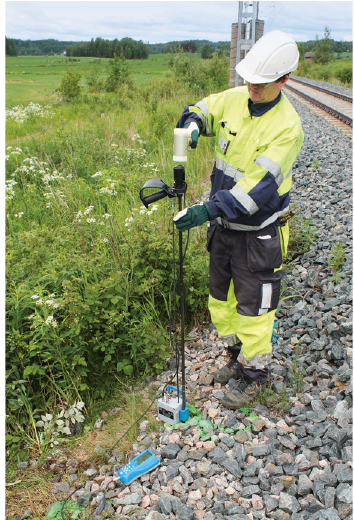
Figure 1. The Panda2